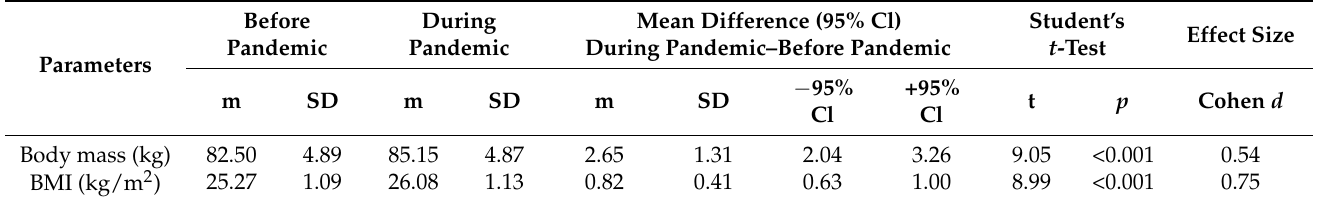
Table 1. Comparison of the results of body build measurements before and during the pandemic. Before Parameters